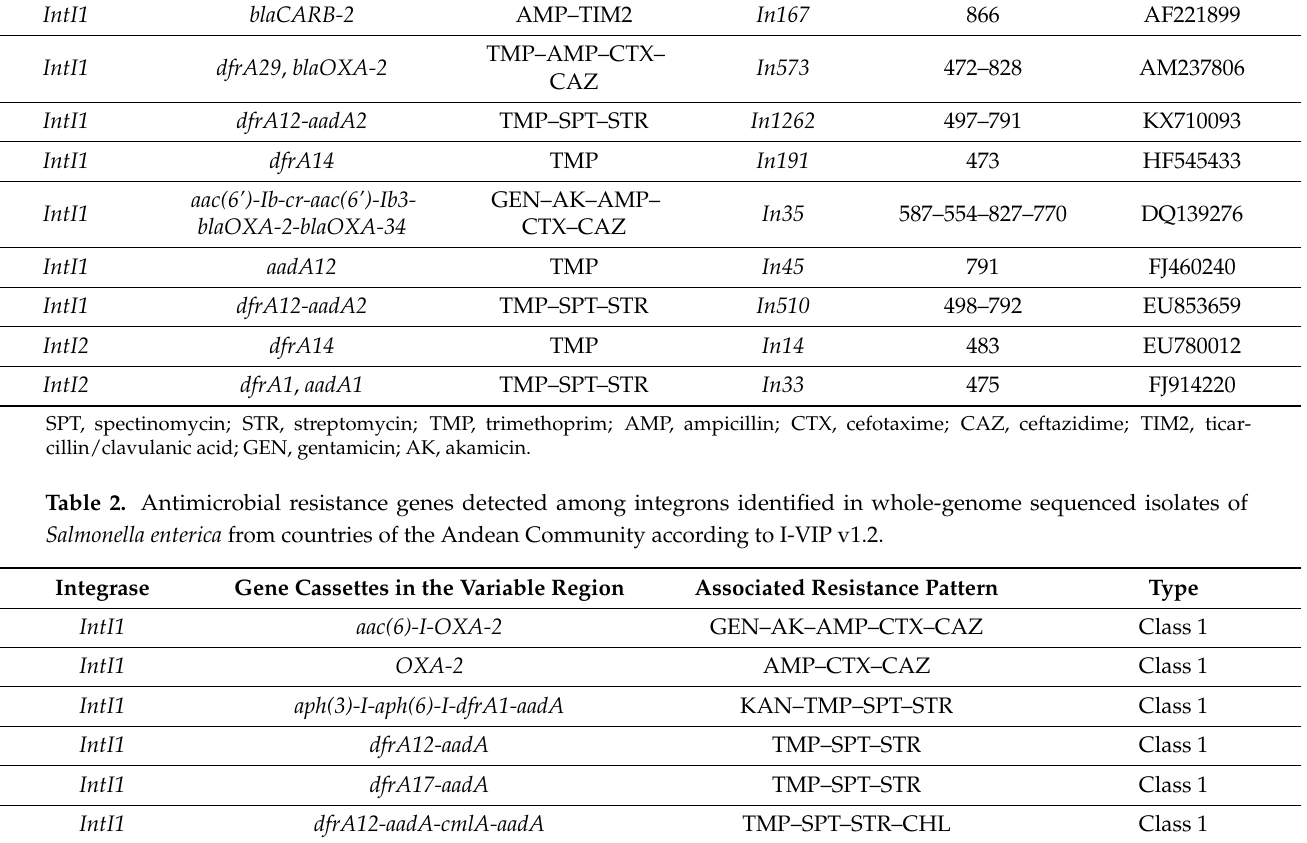
Table 1. Antimicrobial resistance genes detected among integrons identified in whole-genome sequenced isolates of Sal- monella enterica from countries of the Andean Community according to IntFinder 1.0.